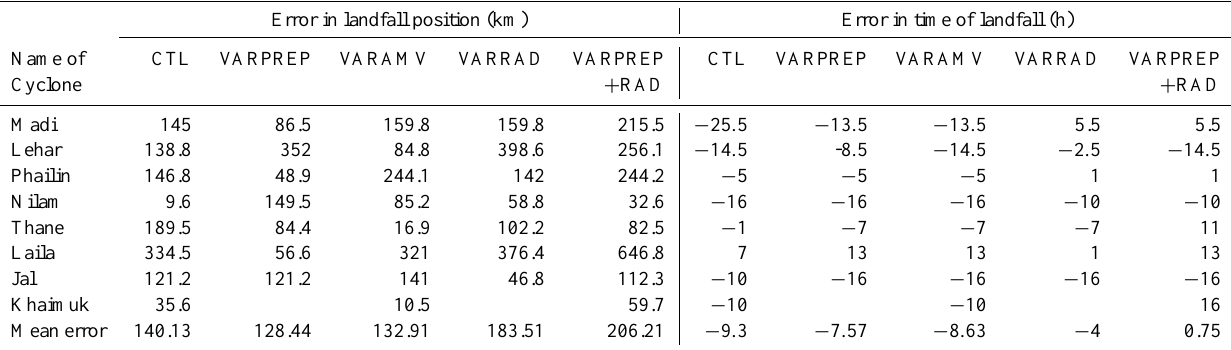
Table 3. Errors in landfall position and landfall timing from various experiments. The negative time errors indicate early landfall and positive errors show late landfall.